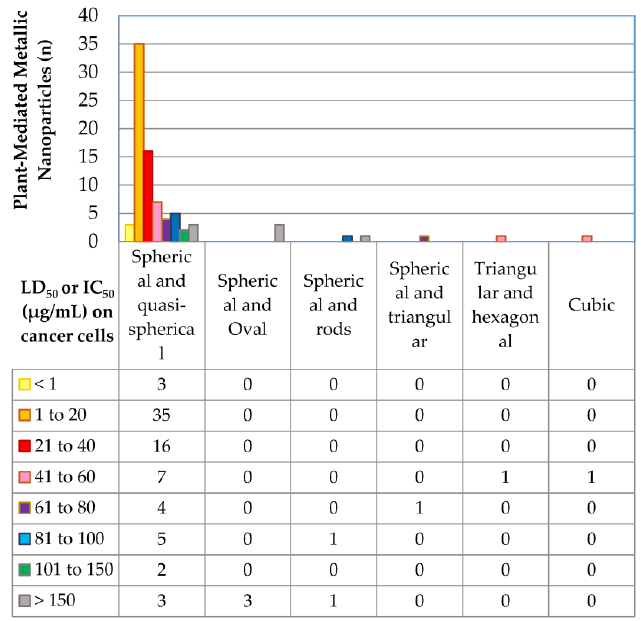
Figure 3. The correlation between plant-mediated syntheses of metallic nanoparticle morphology and